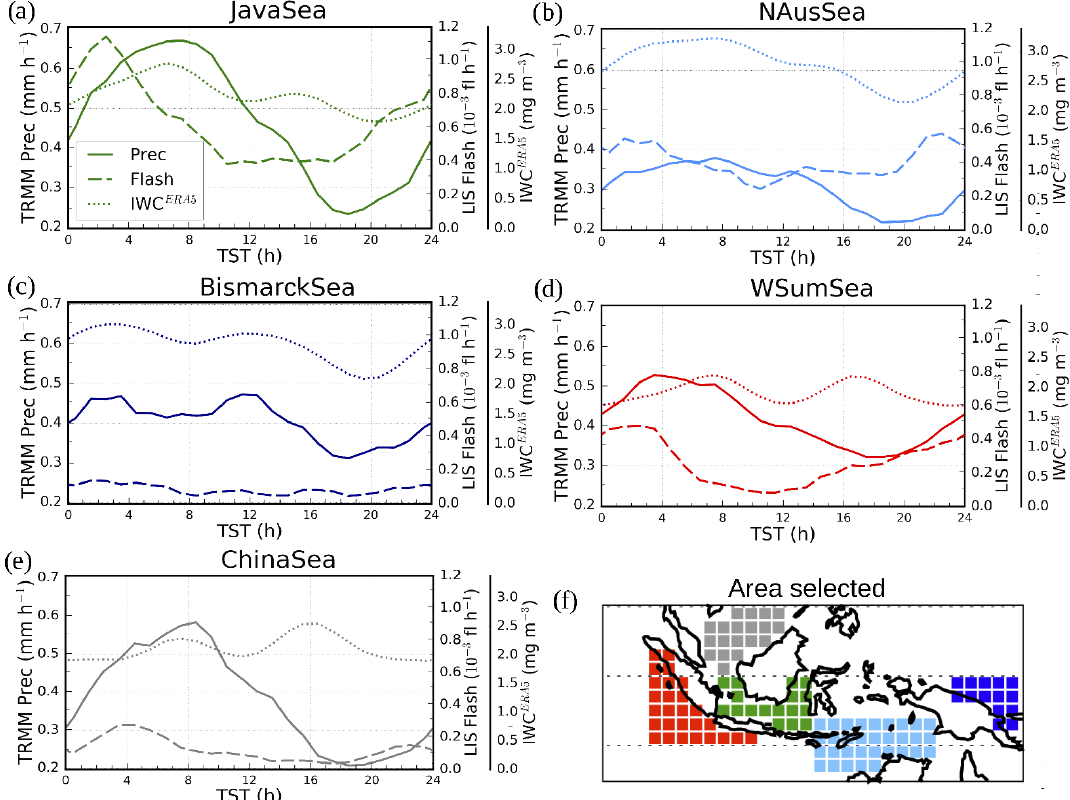
Figure 9. Diurnal cycles of Prec (solid line), Flash (dashed line) and IWC ERA5 from ERA5 at 150hPa (dotted line) over MariCont seas: Java Sea (a) , North Australia Sea (NAusSea) (b) , Bismarck Sea (c) , West Sumatra Sea (WSumSea) (d) and China Sea (e) and map of the study zones over sea (f)